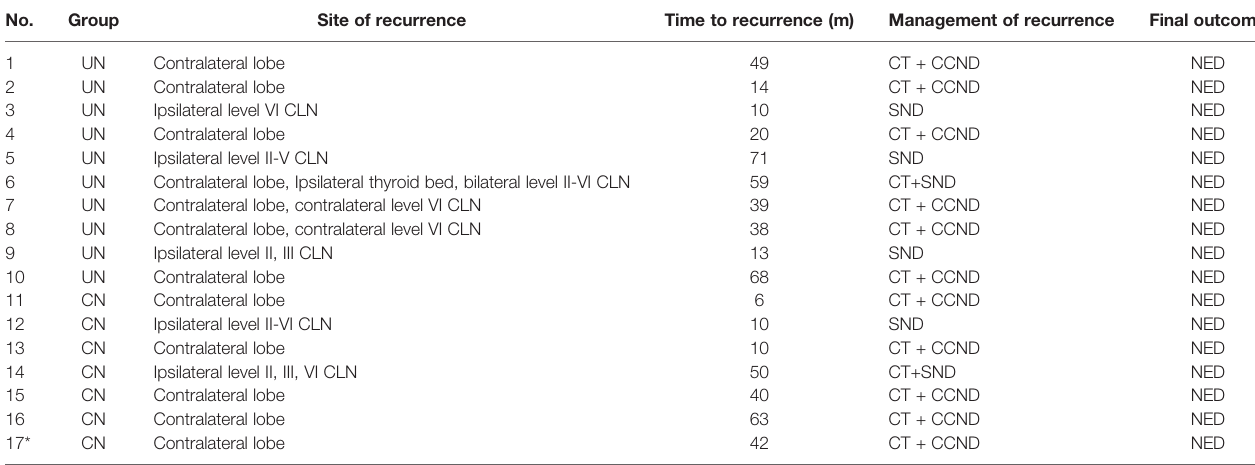
TABLE 4 | Cases of patients with recurrence.